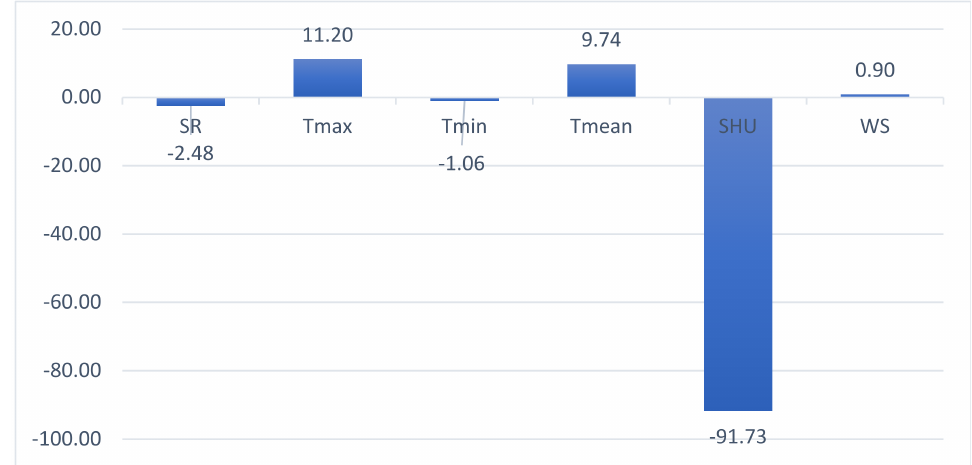
Figure 3. Contribution of climatological factors to